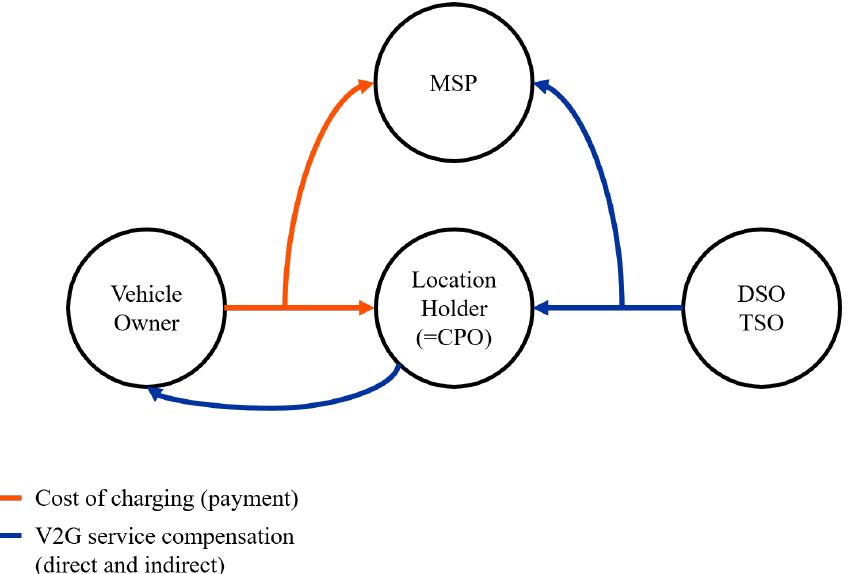
Figure 2. Definition of a semi-public charging case (following [25], own